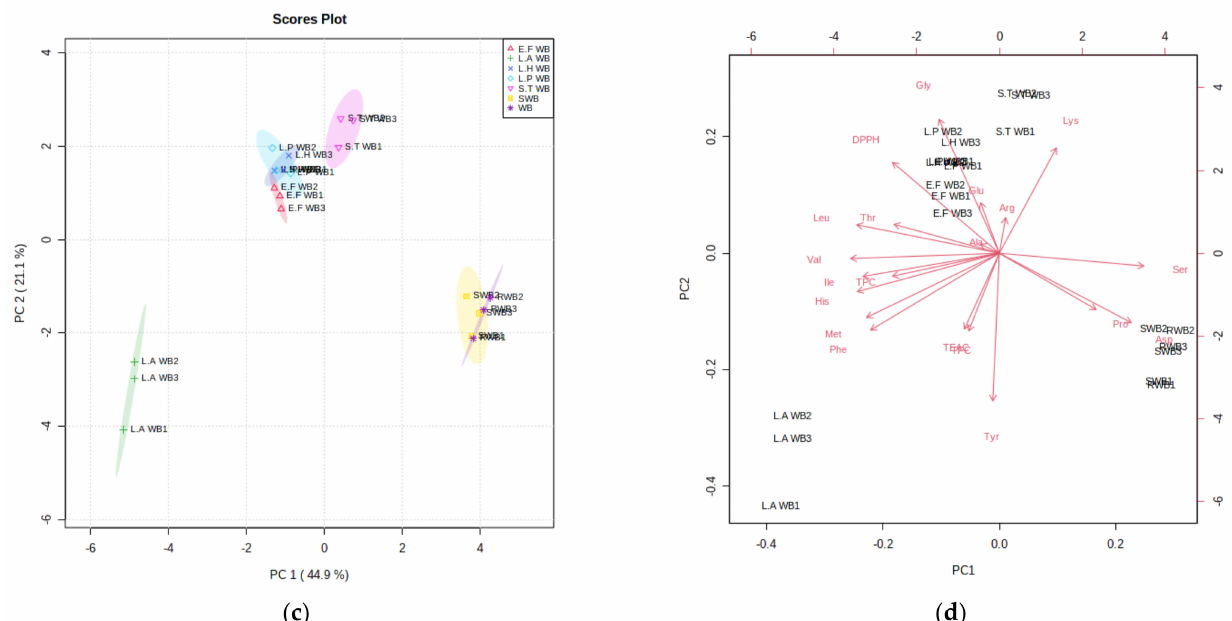
Figure 3. Hierarchical clustering dendrogram ( a ), heatmap ( b ), principal component analysis (PCA) score plot ( c ), and biplot ( d ) of raw and fermented wheat bran clustered with Ward’s algorithm with Euclidean distance measure. RWB, raw wheat bran; SWB, sterilized wheat bran; L.A WB, wheat bran fermented with L. acidophilus ; L.P WB, wheat bran fermented with L. plantarum ; L.H WB, wheat bran fermented with L. helveticus ; S.T WB, wheat bran fermented with S. thermophilus ; E.F WB, wheat bran fermented with E. faecalis